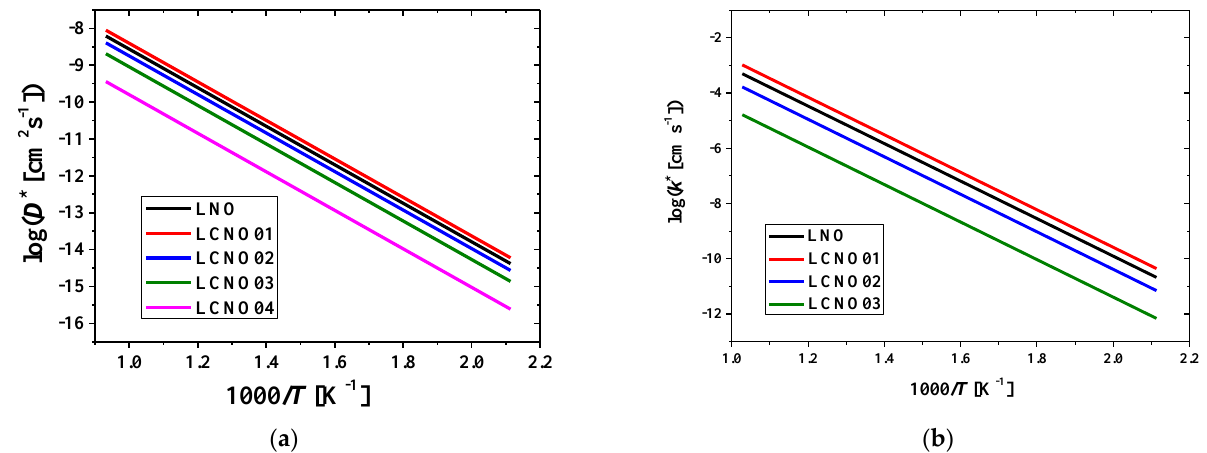
Figure 7. Arrhenius plots for the oxygen tracer diffusion coefficient ( a ) and surface exchange constant ( b ) values for the La 2−x Ca x NiO 4+δ samples according to the TPIE with C 18 O 2 data.